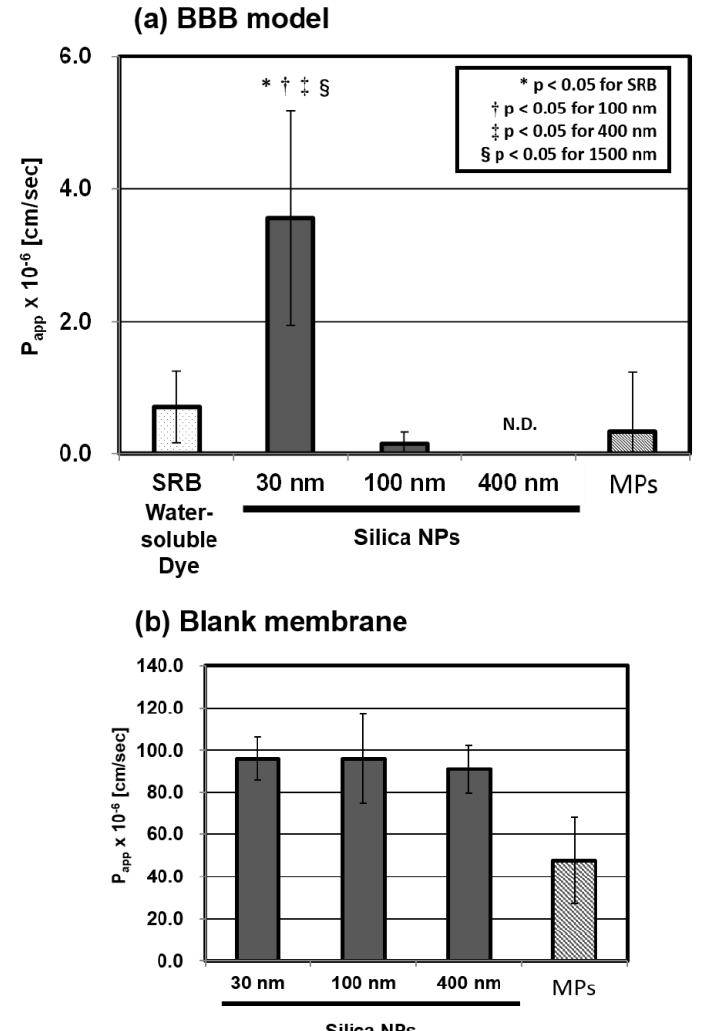
Figure 1. Permeability coefficients ( P ) using: ( a ) in vitro BBB model; and ( b ) blank app membrane, for the four sizes of fluorescent silica particles (30, 100, 400 nm and micro-particles (MPs)) and sulforhodamine B (SRB). We tested the silica particles at the concentration of 1.0 mg/mL and SRB at the concentration of 0.87 μM, in 30 min